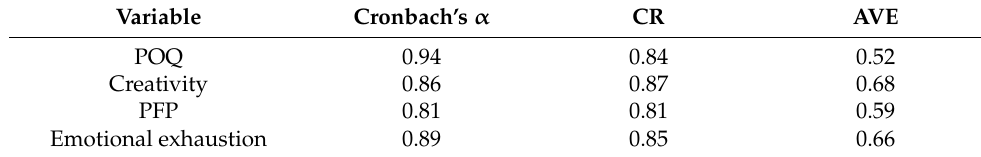
Table 3. Reliability and validity of